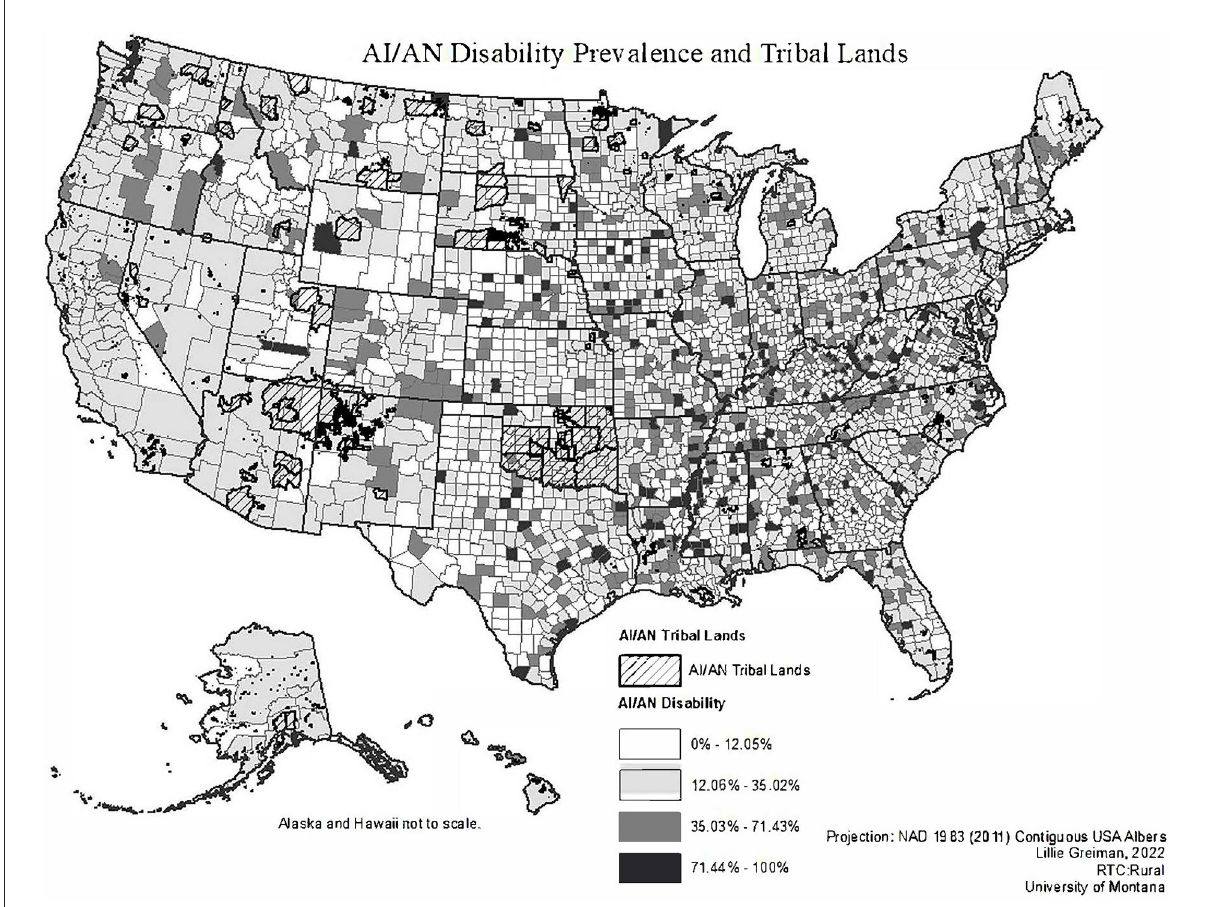
FIGURE1 Map of AI/AN disability prevalence overlayed with AI/AN tribal reservation and trust lands.